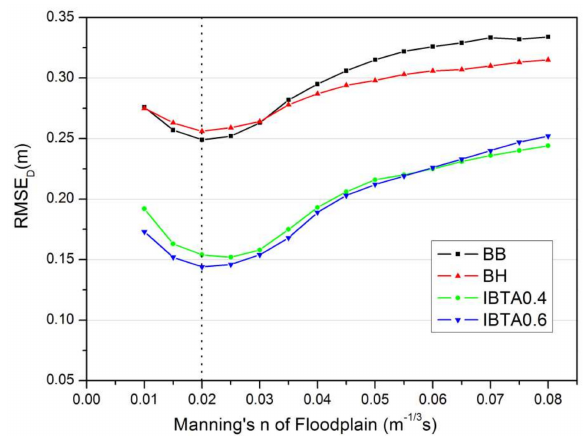
Figure 10. Model response of RMSE D for varying Manning’s n value of floodplain. The dotted line represents the optimal Manning’s n value of floodplain used in this